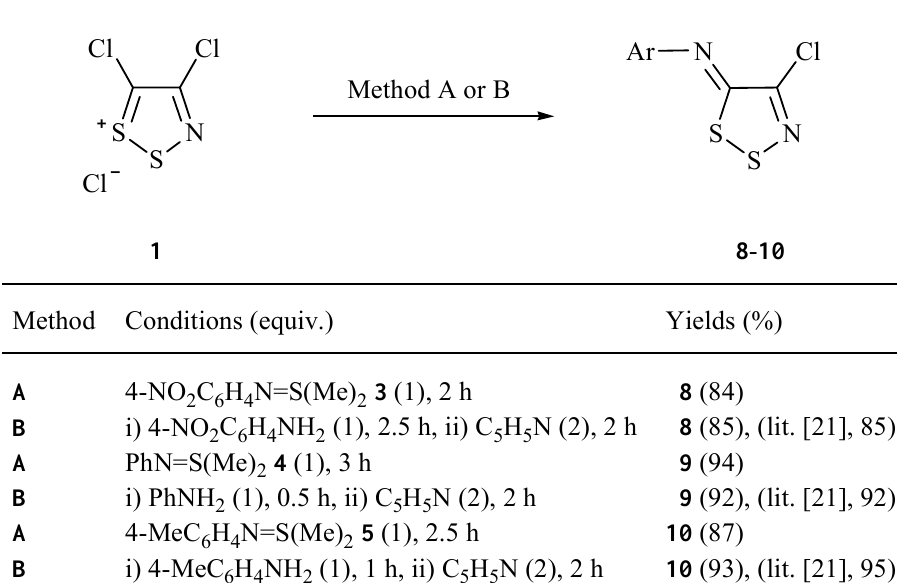
Table 1. Reaction of Appel salt 1 (0.96 mmol) with: sulfimides (Method A) and anilines (Method B), in dry DCM, at ca. 20